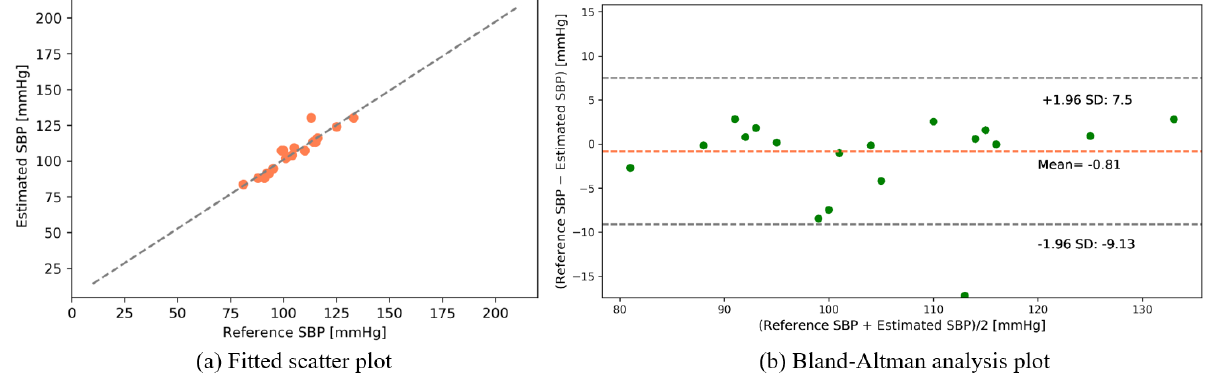
Figure 15. SBP estimation (self-made dataset).